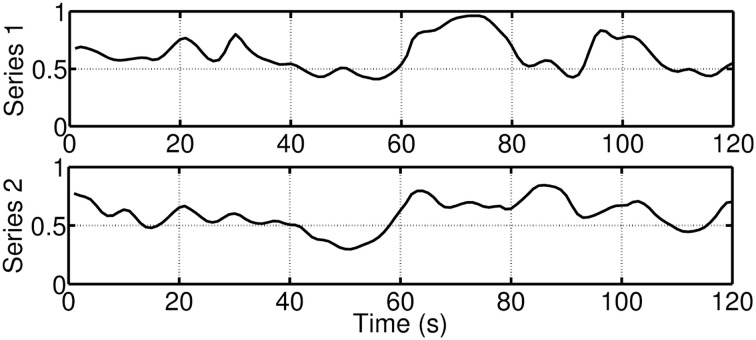
Example for two overall synchrony measures for two participants. During the first 60 s, the participants were watching a film clip, which was rated as moderately funny. During the last 60 s, the participants were shown a funnier film clip.